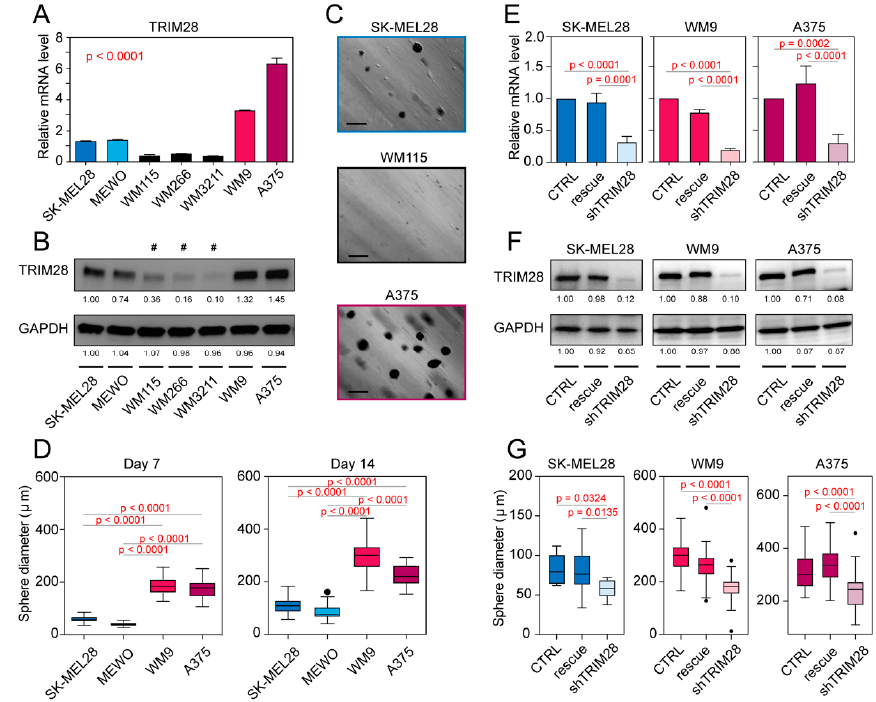
Figure 3. TRIM28 high expressing melanoma cell lines possess a higher potential of melanosphere formation. ( A ) Relative expression of TRIM28 in a panel of 7 melanoma cell lines. n = 3 biological replicates; bar—the mean gene expression; whiskers—SD. The statistical significance is presented in